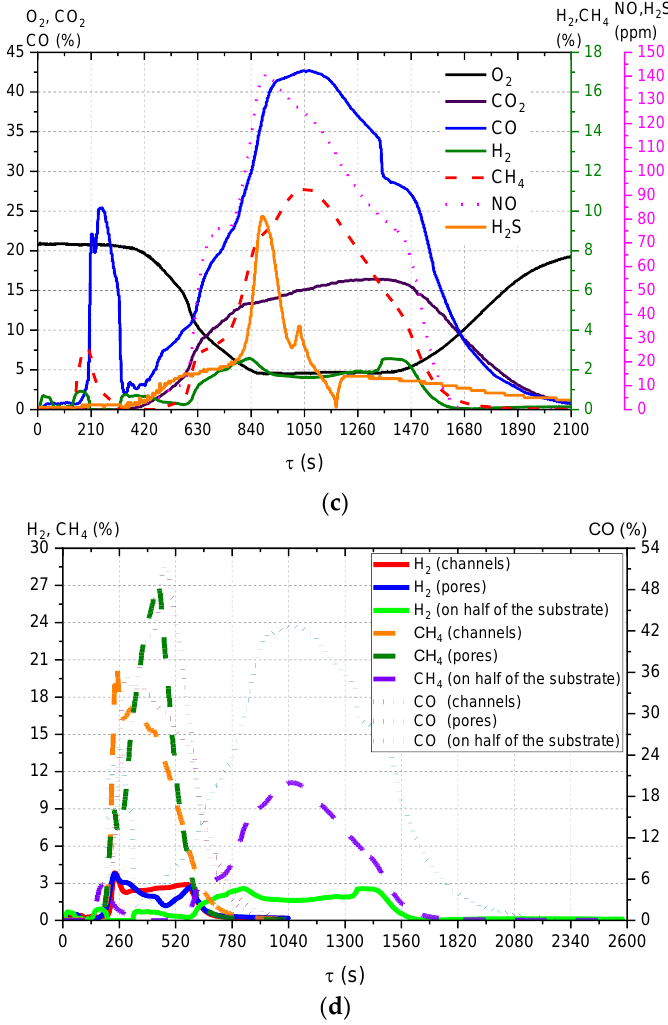
Figure 13. Trends of the concentrations of gas mixture components when varying the biomass surface structure: artificial channels ( a ); artificial pores ( b ); uniform layer ( c ); comparison of gas concentrations ( d ) .